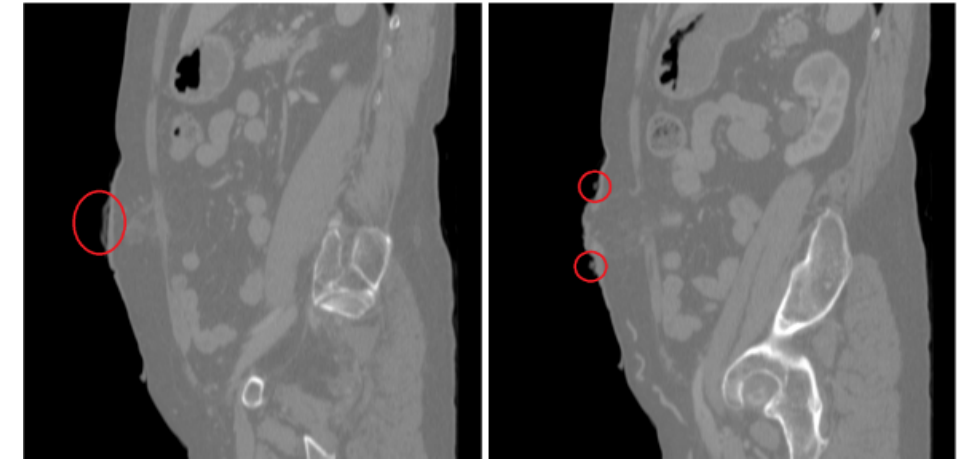
Figure 10. Profile of the segmented ROI (red circle points the patch